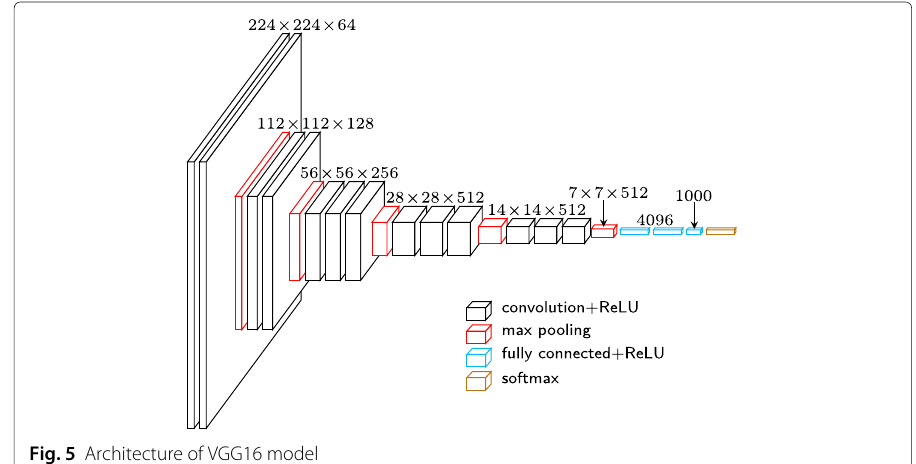
Fig. 5 Architecture of VGG16